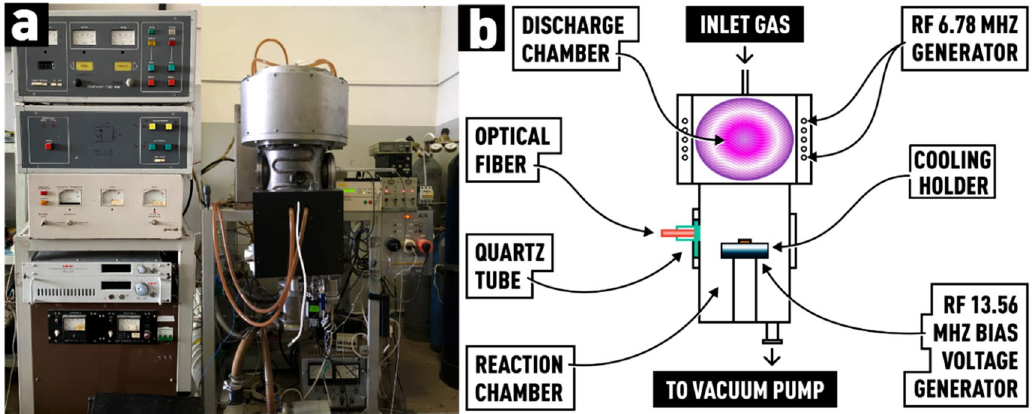
Figure 1. ( a ) General view of the PCE system; ( b ) schematic drawing of the processing and plasma